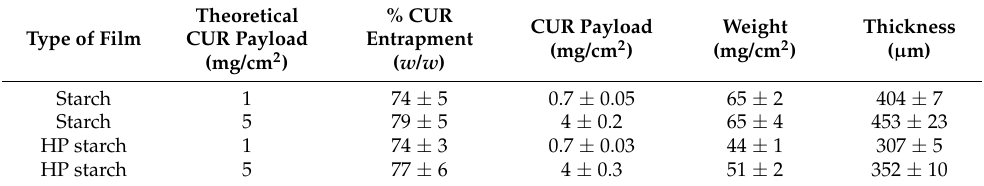
Table 3. Physical characteristics of the unmodified starch and HP starch films ( n = 10, mean ± stdev). Type of